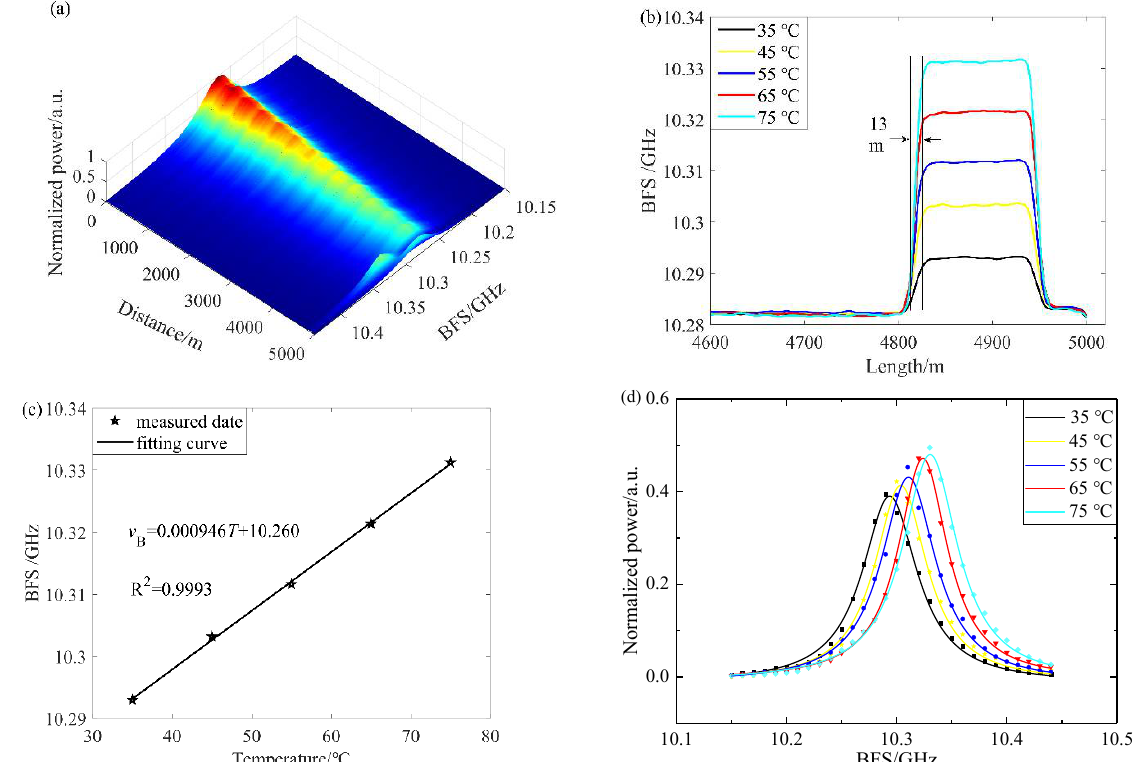
Figure 9. Temperature measurement results of SMF alignment fusion to 50 µ m GI-MMF. ( a ) three- dimensional BGS of the whole sensing structure at a heating section of 75 °C; ( b ) BFS at 35–75 °C; ( c ) Linear fitting between BFS and temperature; ( d ) BGS at different temperatures.